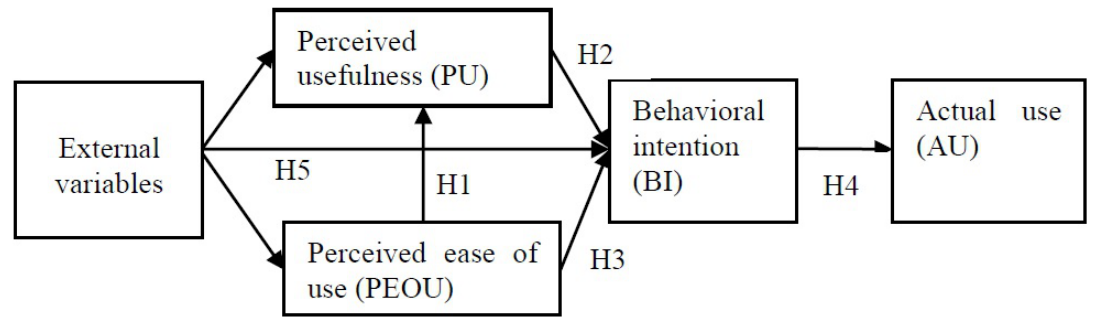
Figure 2. Revised